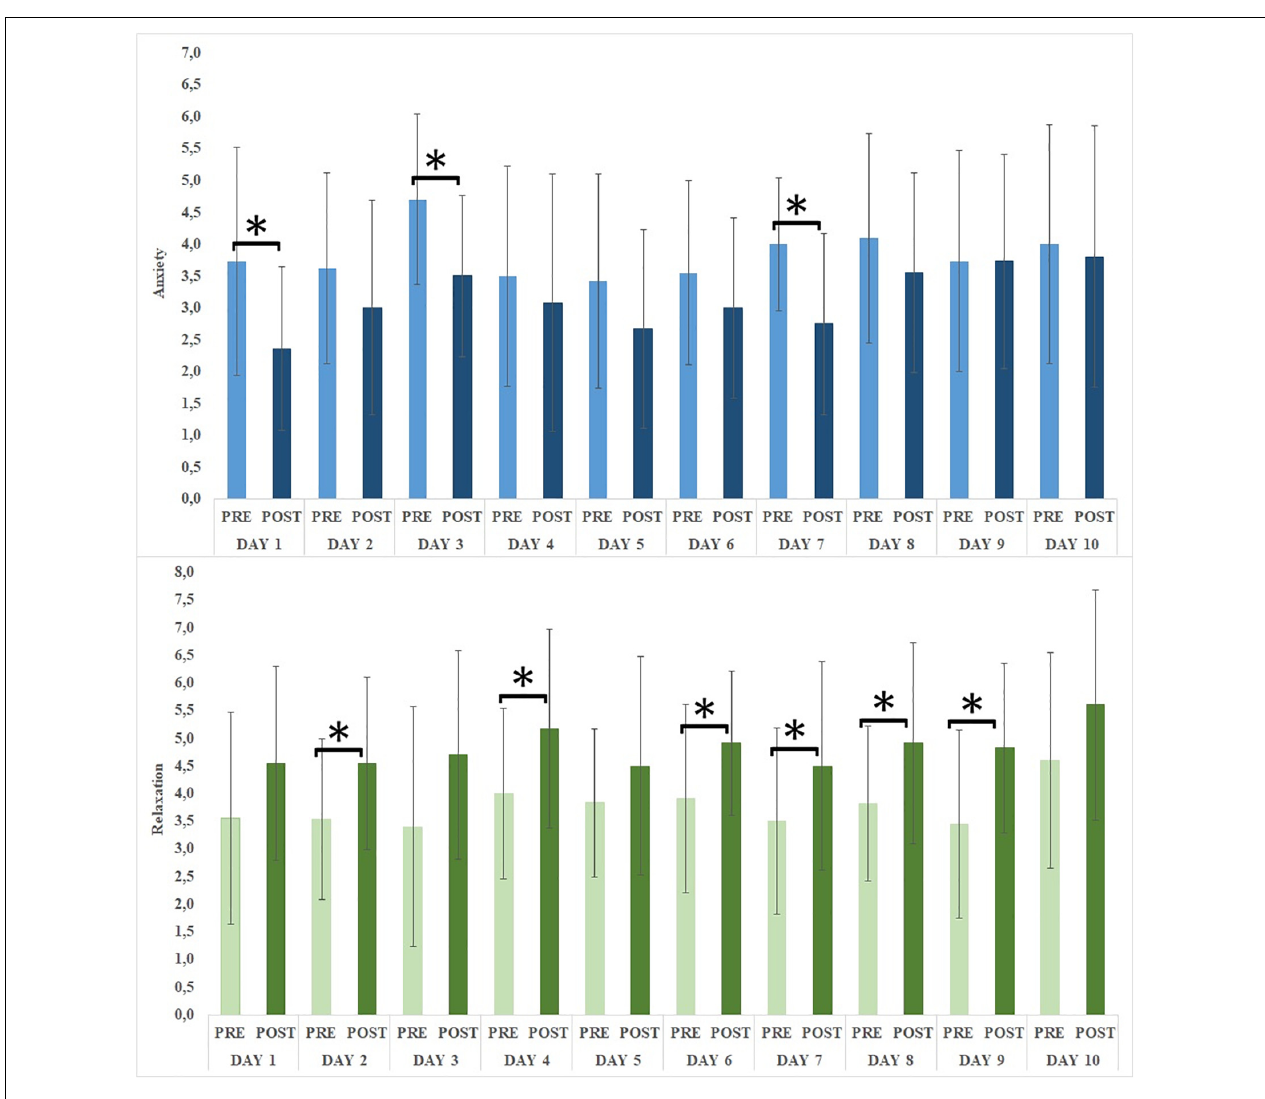
FIGURE 5 | Emotional changes (anxiety and relaxation). Error bars: ± 1 SD; ∗ significant